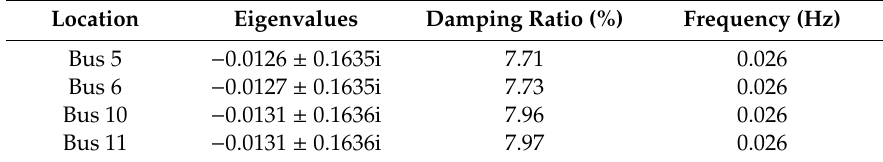
Table 4. The ultralow-frequency oscillation modes for PV generation connected to di ff erent locations.